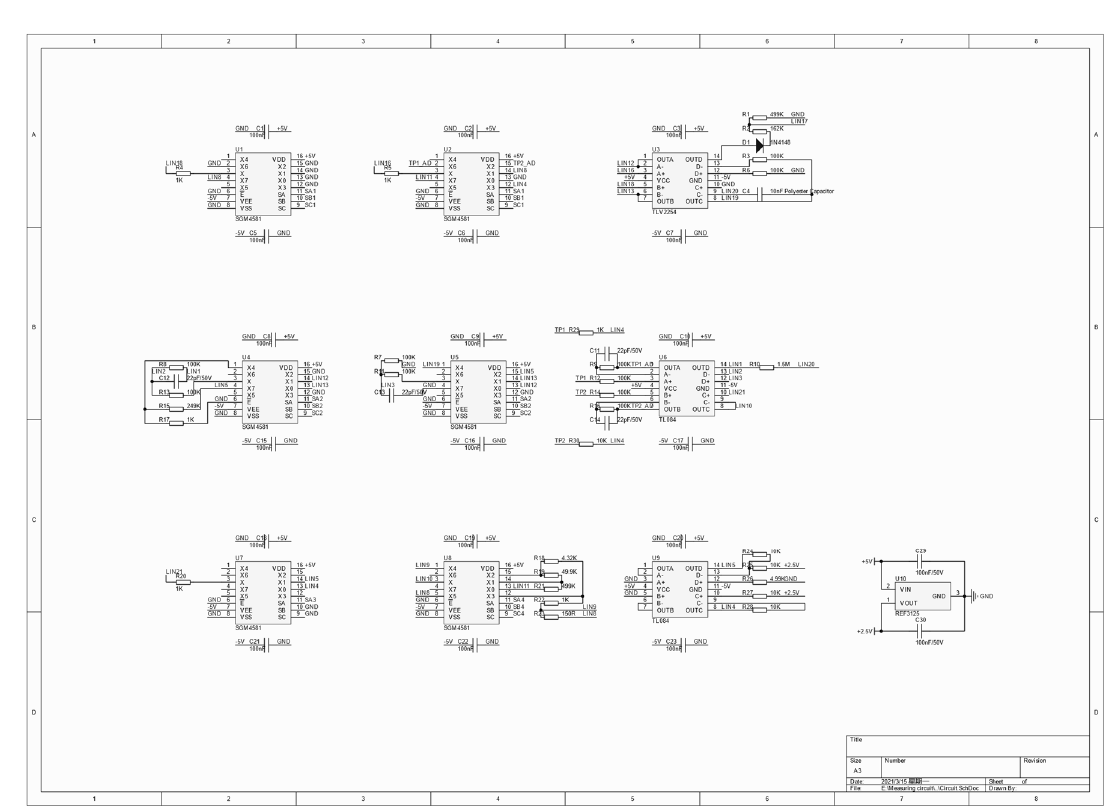
Figure A1. Circuit diagram of measuring